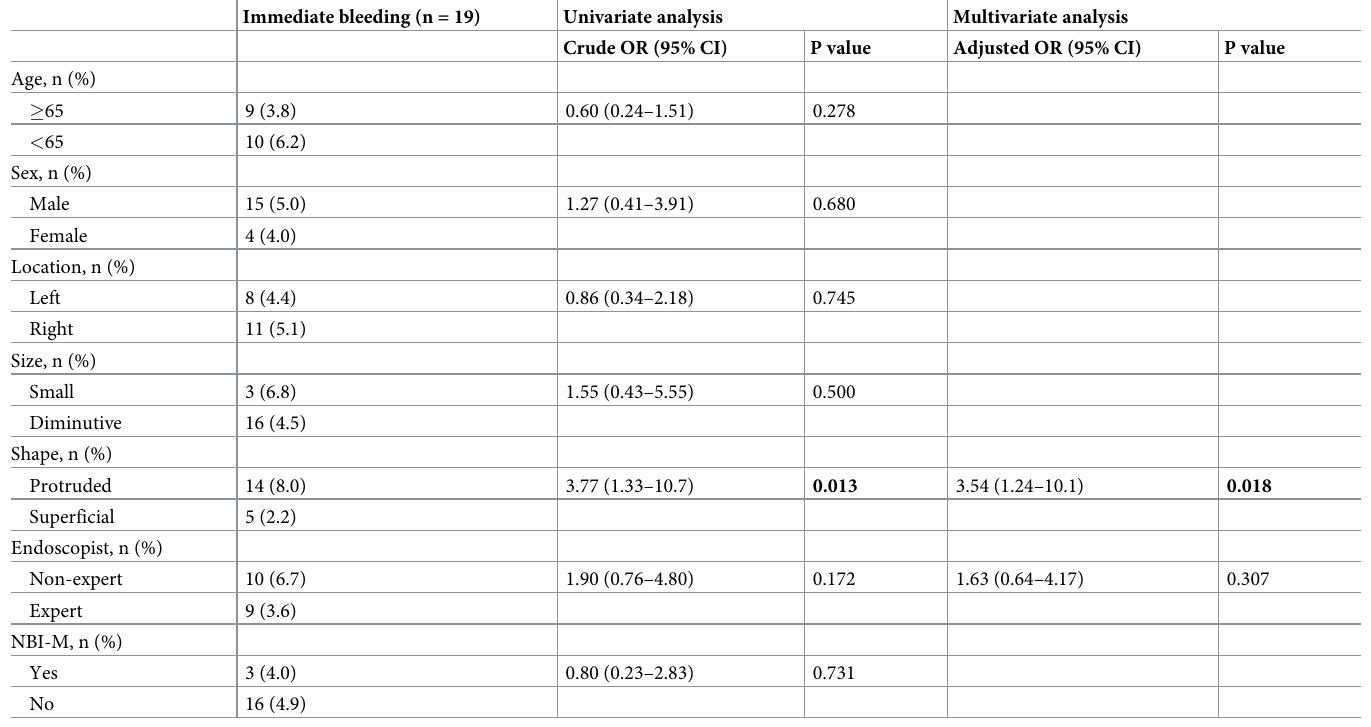
Table 5. Risk factors for immediate post-CSP bleeding (n =